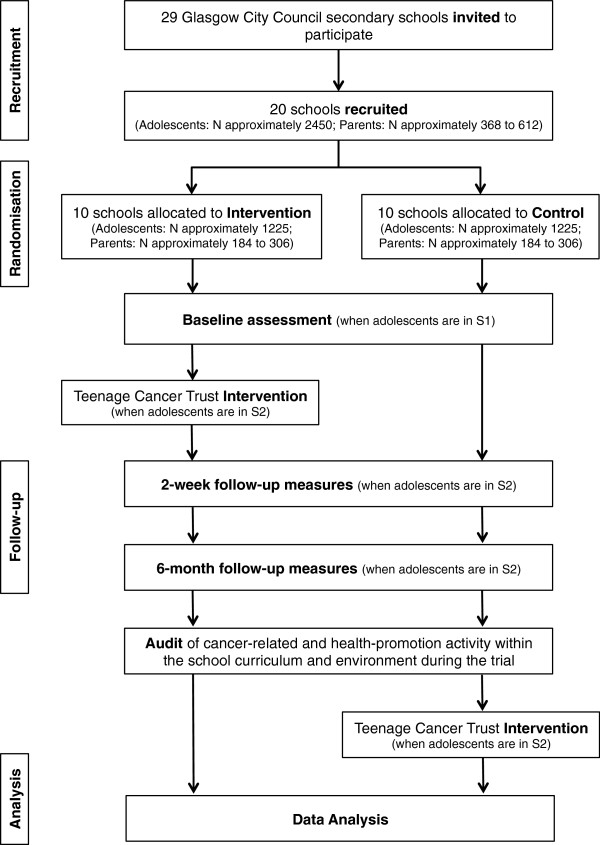
Study flow chart.